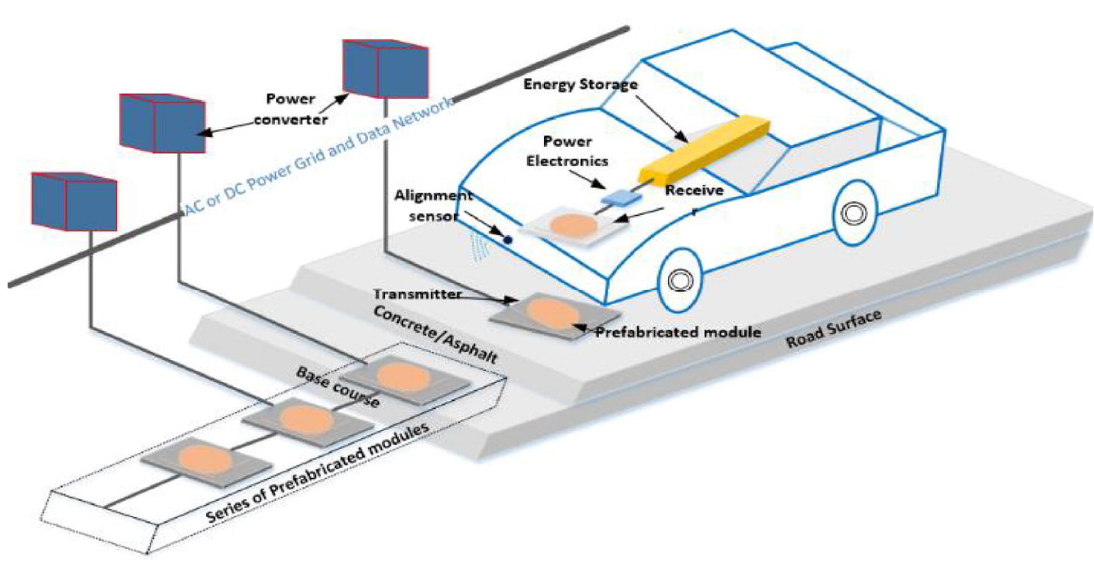
Figure 3. Dynamic wireless charging [92].